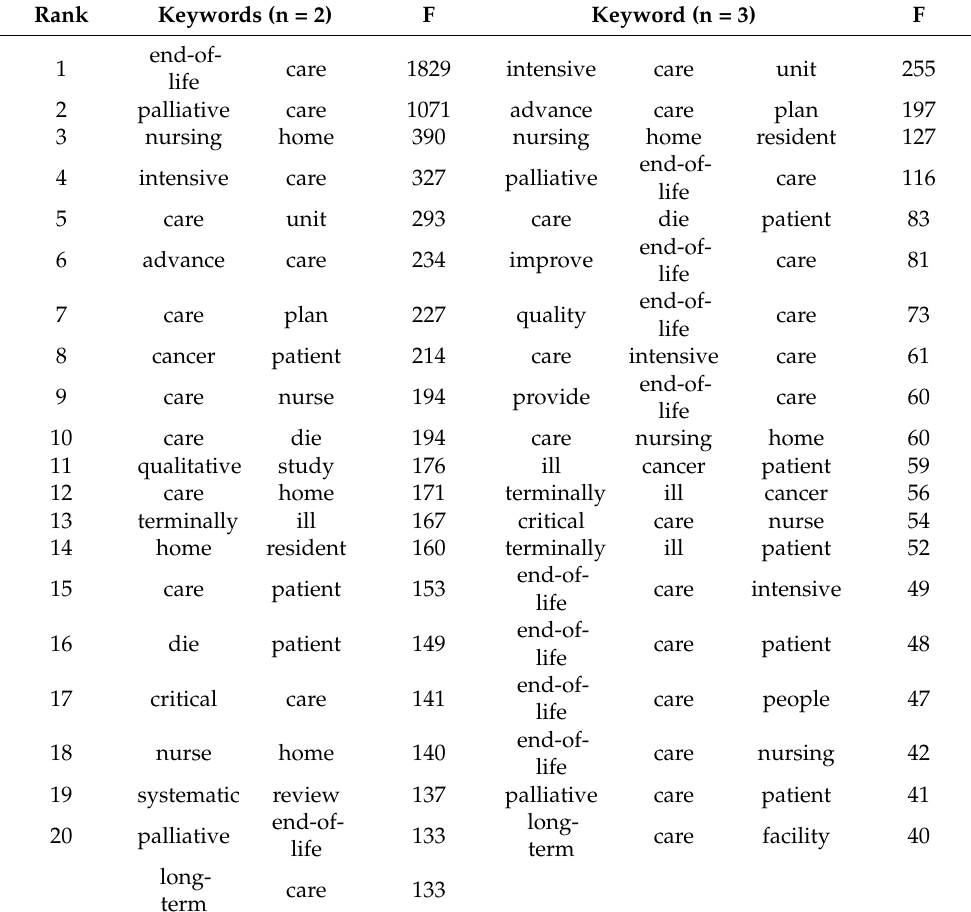
Table 3. Frequency for the top 20 contiguous sequence keywords according to the number of adjacent words from EOL